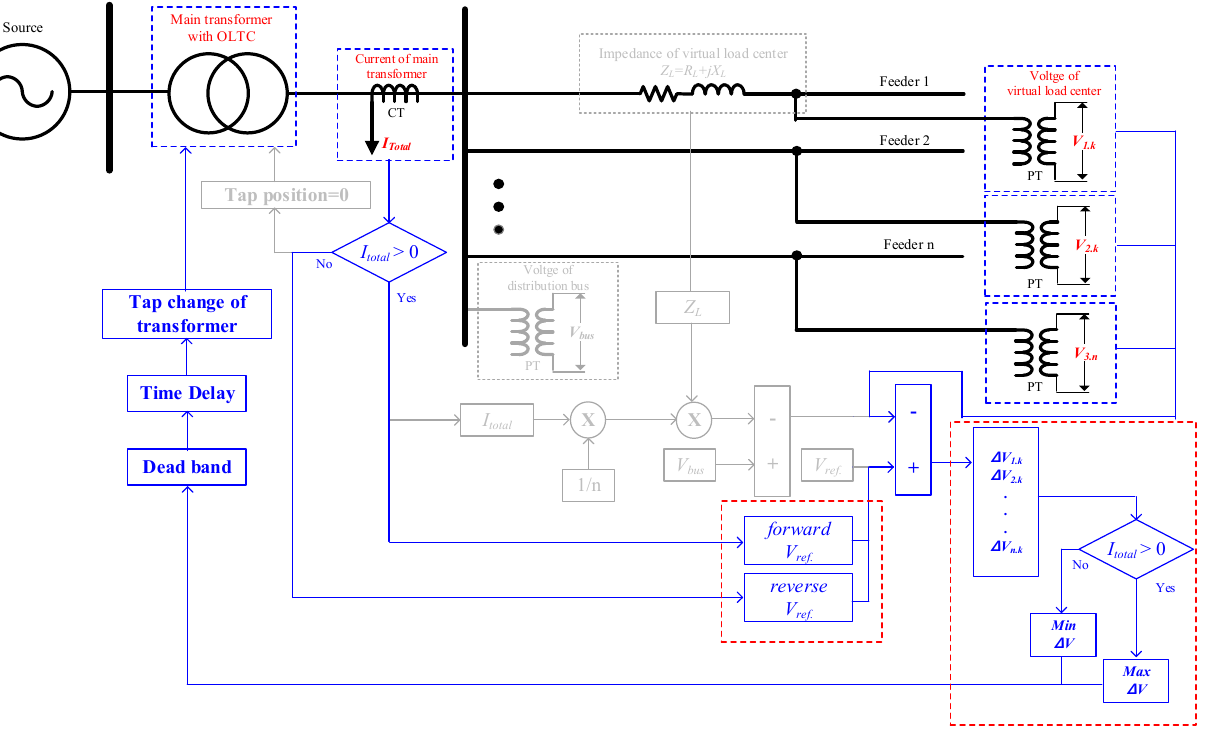
Figure 4. Mechanism of the proposed method.